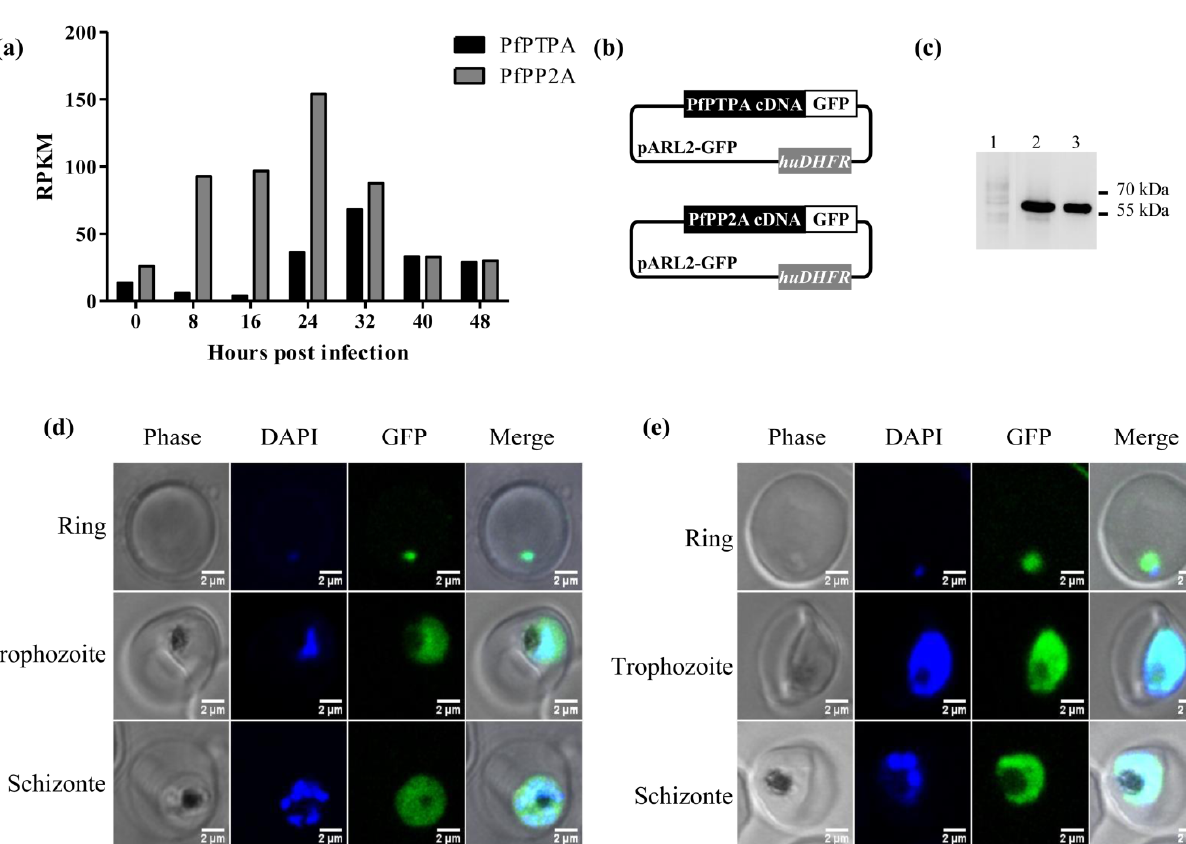
Figure 2. Expression of pfptpa and pfpp2a gene by Plasmodium falciparum